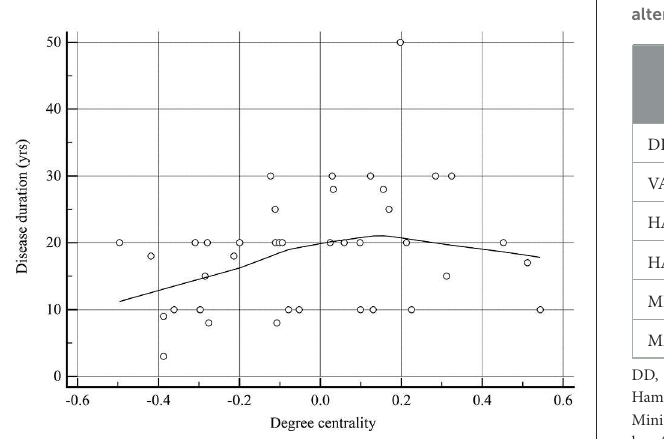
FIGURE10 There was a significant positive correlation between degree centrality of the brain regions with altered NVC and disease duration in patients with MOH.